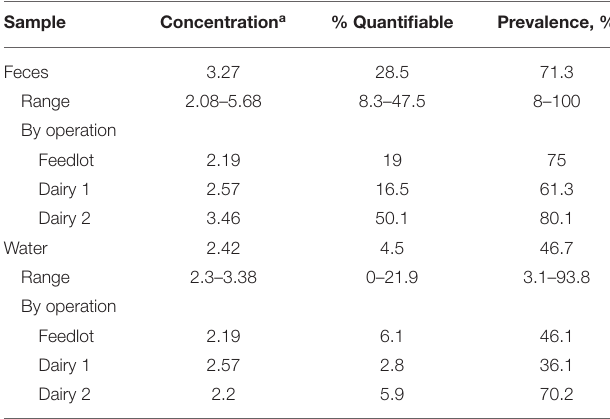
dispersion of data due to clustering within each cohort.